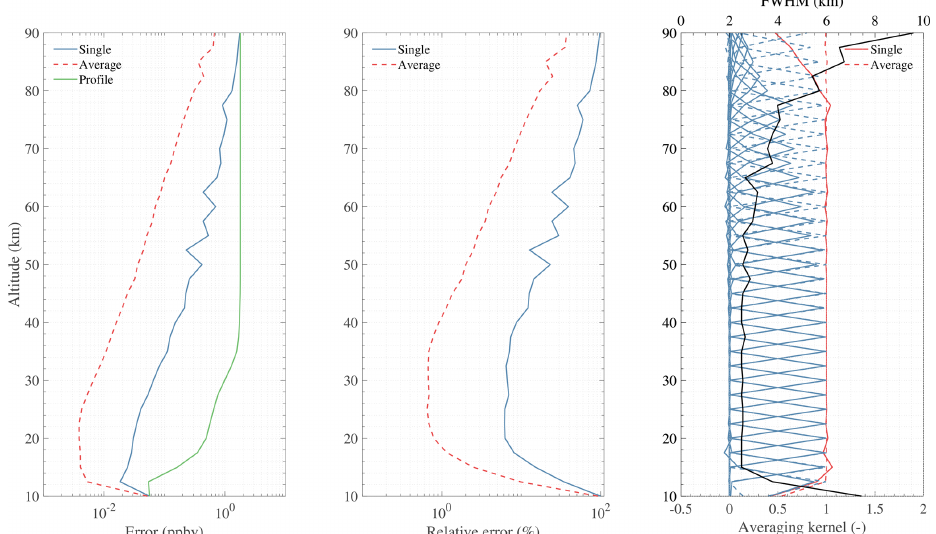
Figure 16. Simulation result of HCl retrieval using 624.9GHz lines. “Single” and “Average” represent the retrieval error using different noise. “Profile” represents the typical profile used in the simulation. The black solid line in the last panel represents the FWHM (i.e. vertical